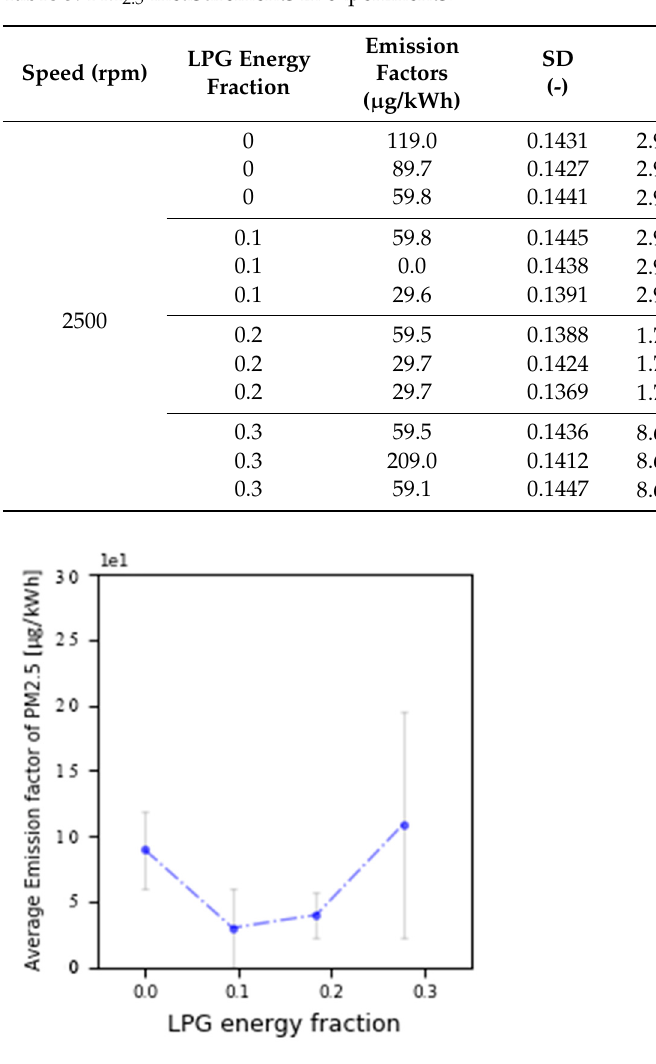
Figure 11. The average emission factor of PM 2.5 at 2500 rpm and full load conditions.